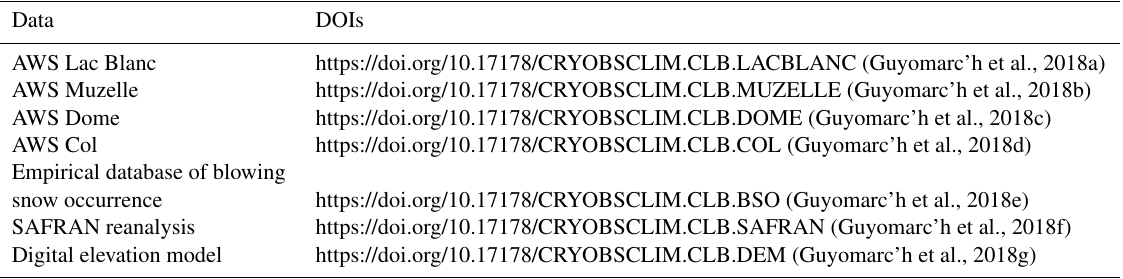
Table 4. Overview of the available data with the corresponding DOIs.